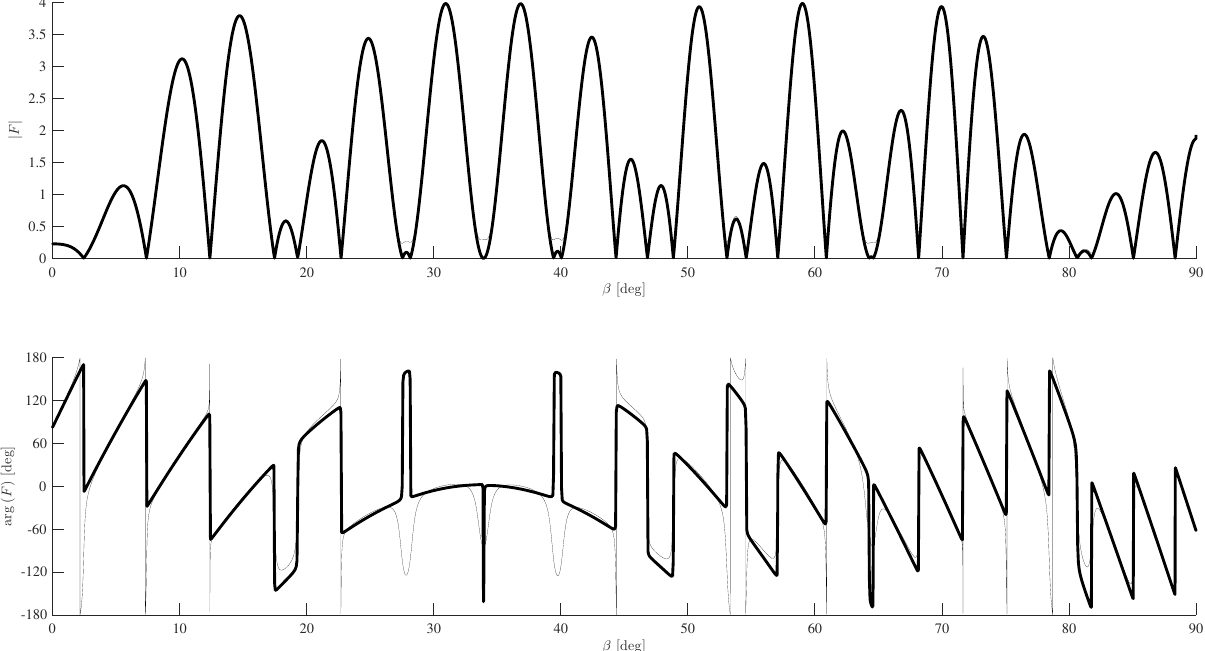
Figure 9: The same as Figure 8 with the source at fixed distance, q = 700.64m , and variable elevation, 0 ≤ β ≤ π /2rad , for the fixed frequency, f = 1000Hz , showing the result of: (i) the exact multipath factor (18) as thin line; (ii) the far field approximation (27) as thick